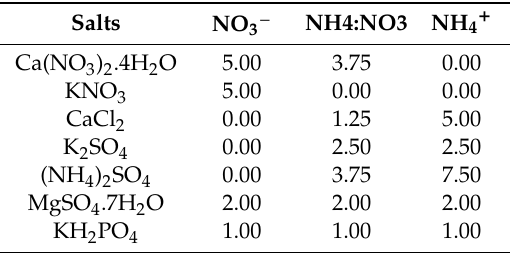
Table 4. The concentrations of salts (mM) used to prepare Hoagland nutrient solutions with dissimilar N sources NO 3 − , NH 4 :NO 3 , and NH 4 + .